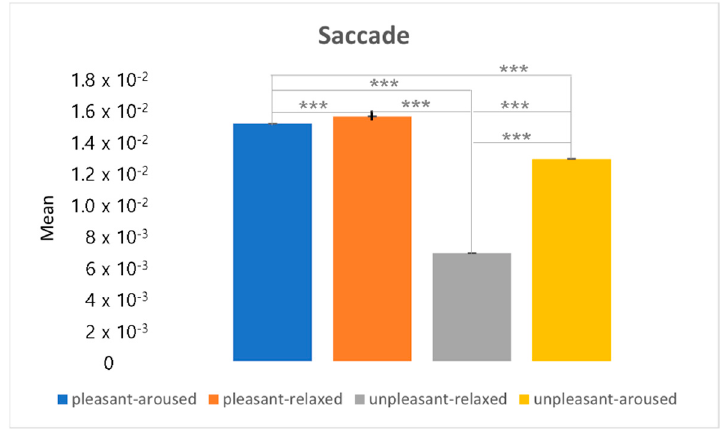
Figure 25. The post hoc analysis on the saccade. *** p < 0.001.